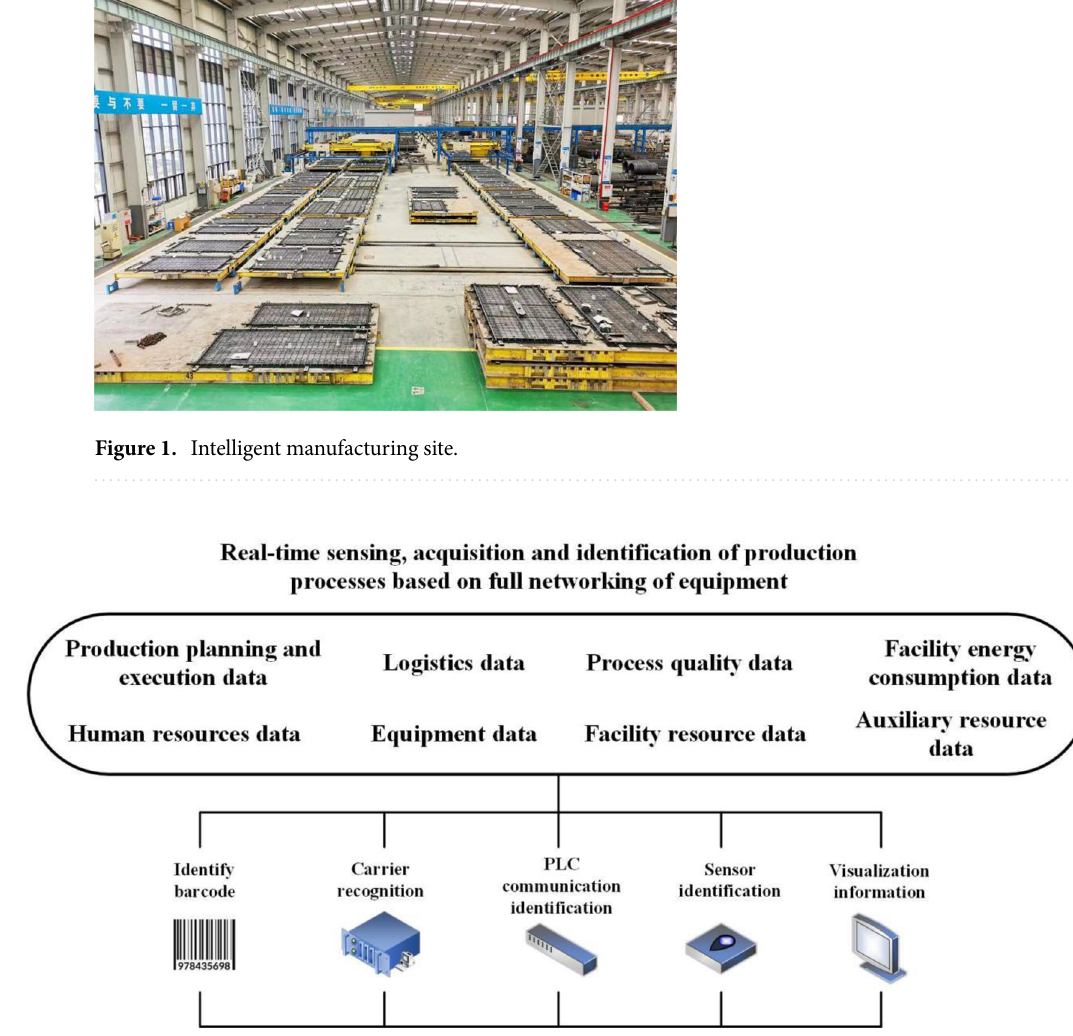
Figure 2. Production process based on equipment full